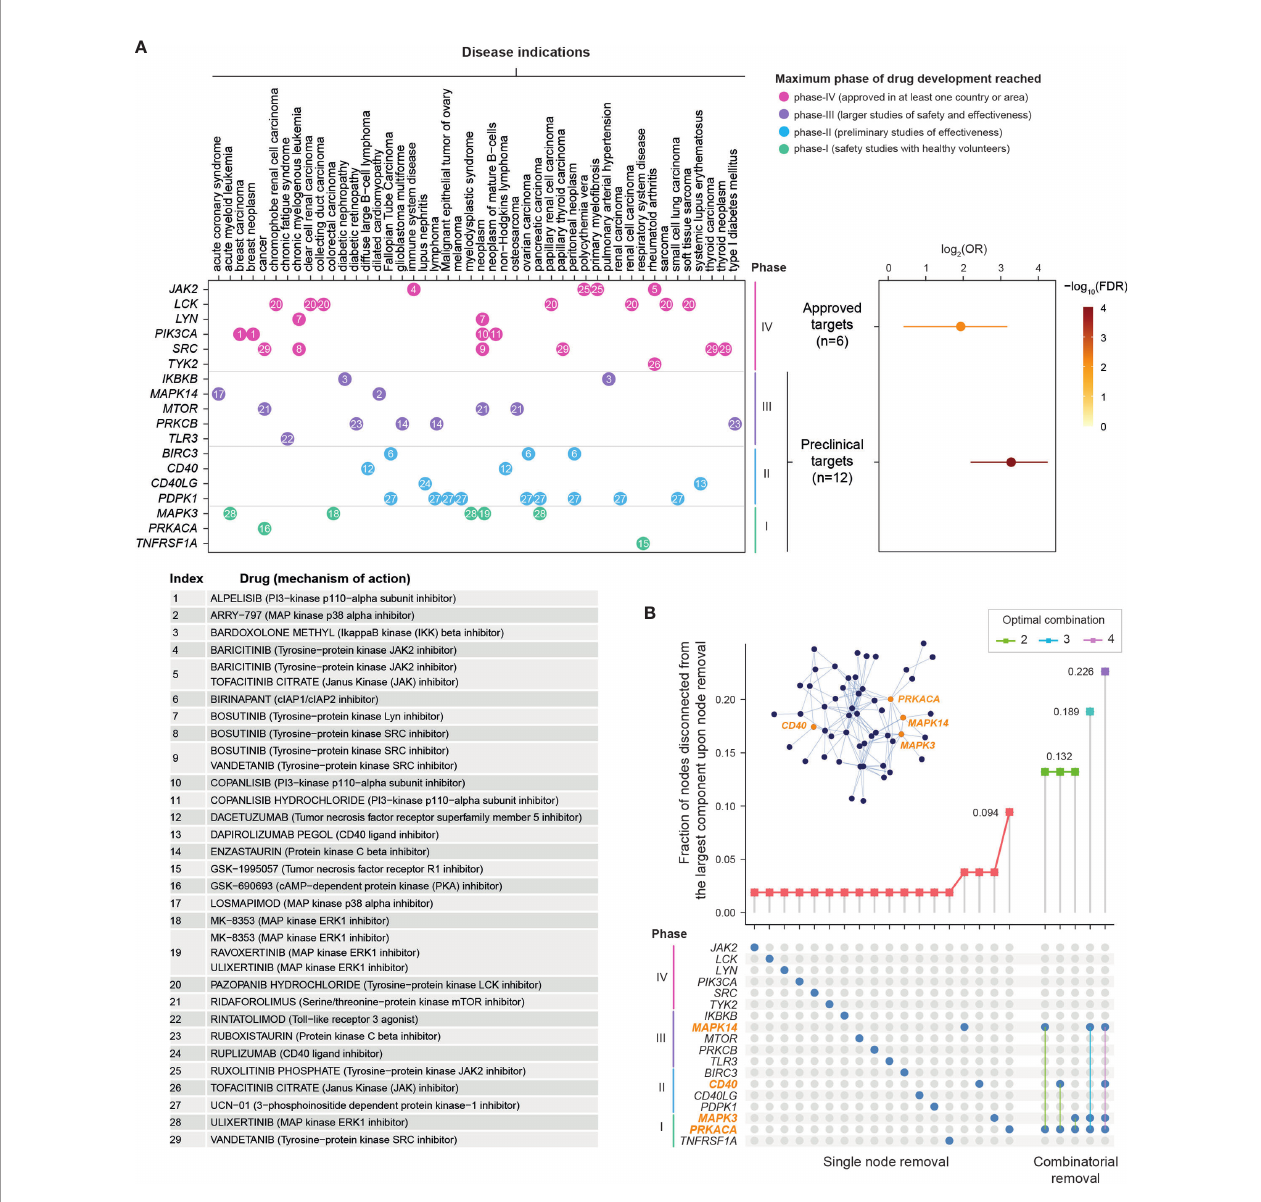
FIGURE 4 | Drug repurposing analysis of pathway crosstalk genes. (A) Support from existing therapeutics. Top-left panel : dot plot showing 18 crosstalk genes ( y -axis) that are currently targeted by approved (phase IV) and phase I/II/III drugs in disease indications ( x -axis). Dots are colored by maximum phase of drug development reached and indexed in number. Bottom-left panel : Information on drugs and mechanism of action. Top-right panel : Forest plots of approved or phased drug targets enriched in crosstalk genes. The signi fi cance level (FDR), odds ratio (OR), and 95% con fi dence intervals (represented by lines) calculated according to Fisher ’ s exact test (one-sided). (B) Rational drug selection. It is based on effects of node removal on the crosstalk. Fraction of nodes disconnected from the largest remaining component ( y -axis) is plotted against node removal ( x -axis). The nodes removed are indicated by blue circles beneath. Notably, nodes removed in combination are indicated by linked blue circles. For each combinatorial removal, only the optimal combinations with the largest effect are shown (also color-coded). Inserted is the illustration of the crosstalk, with the same layout as shown in Figure 3A but only labeled for four nodes in optimal